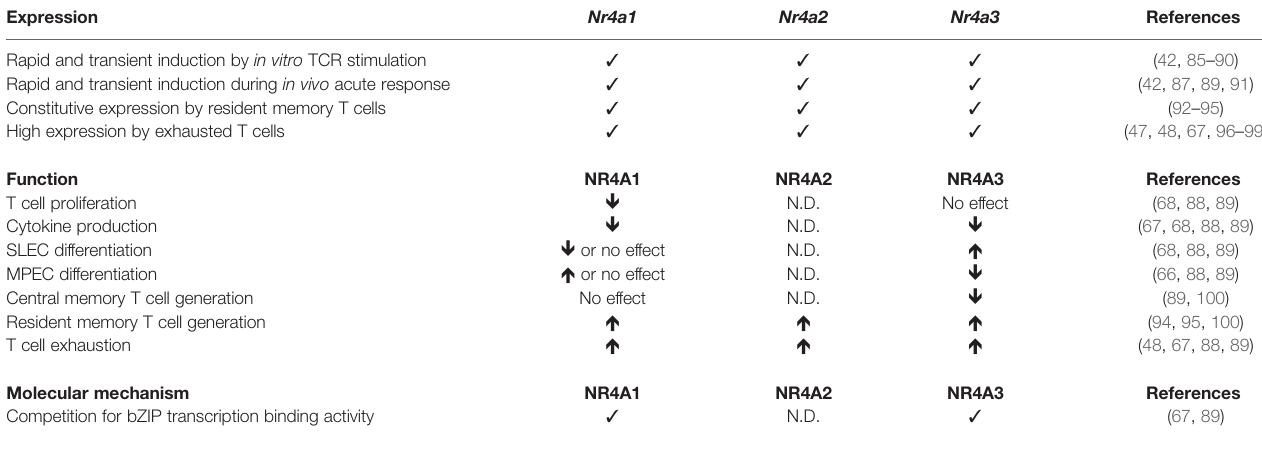
TABLE 1 | Role of NR4A family members in CD8 T